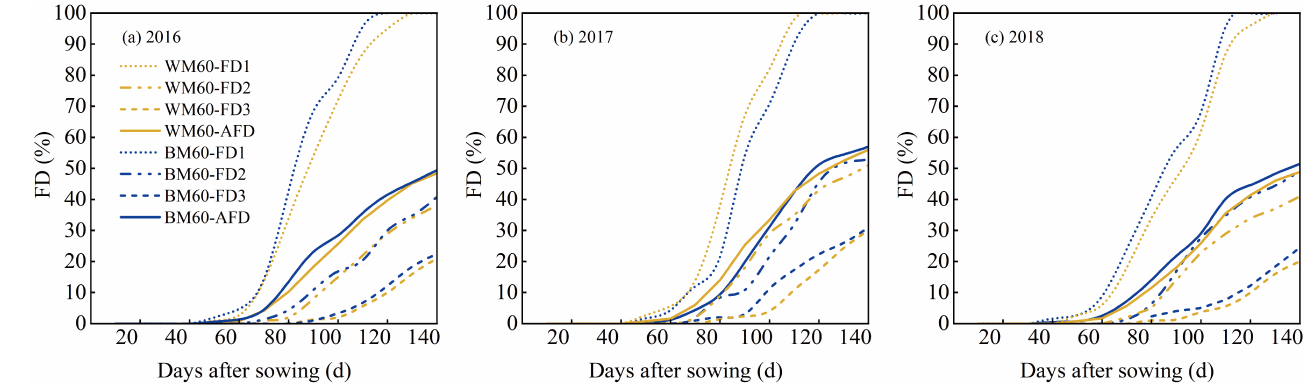
Figure 2. Degradation rates of biodegradable mulches in Zones I, II, and III. WM60, white degradable mulch films with induction periods of 60 d. BM60, black degradable mulch films with induction periods of 60